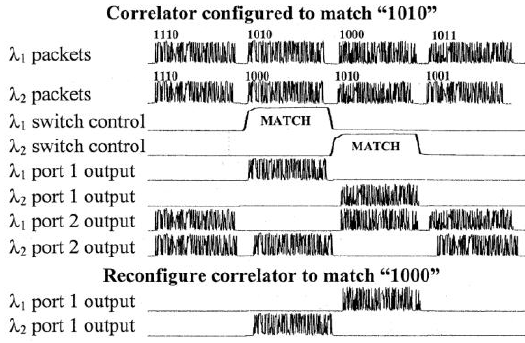
Figure 7. Experimental optical header correlator results, showing actual match signals and ability to reconfigure.